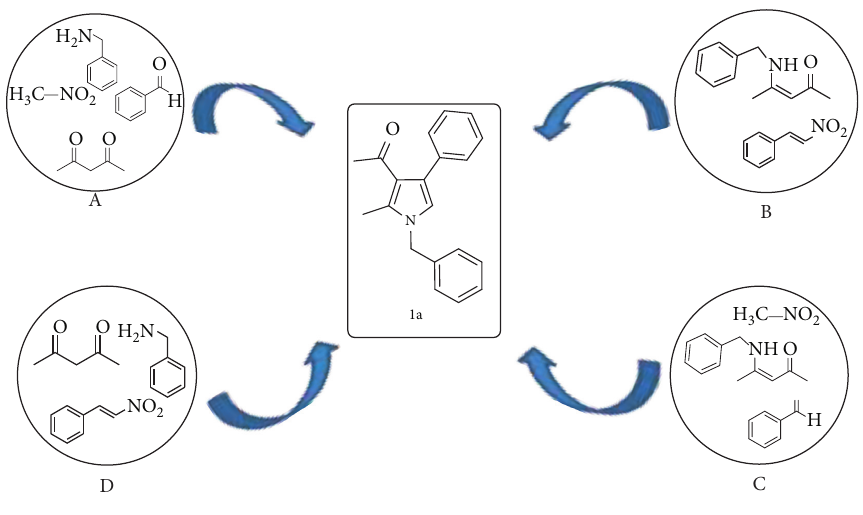
Scheme 1: Synthesis routes of pyrrole